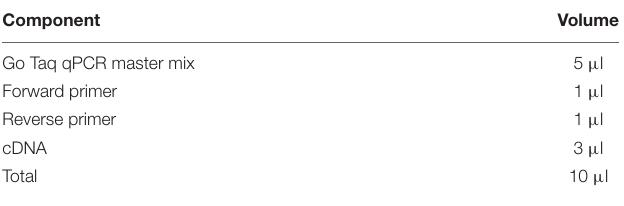
TABLE 10 | qRT-PCR master mix.